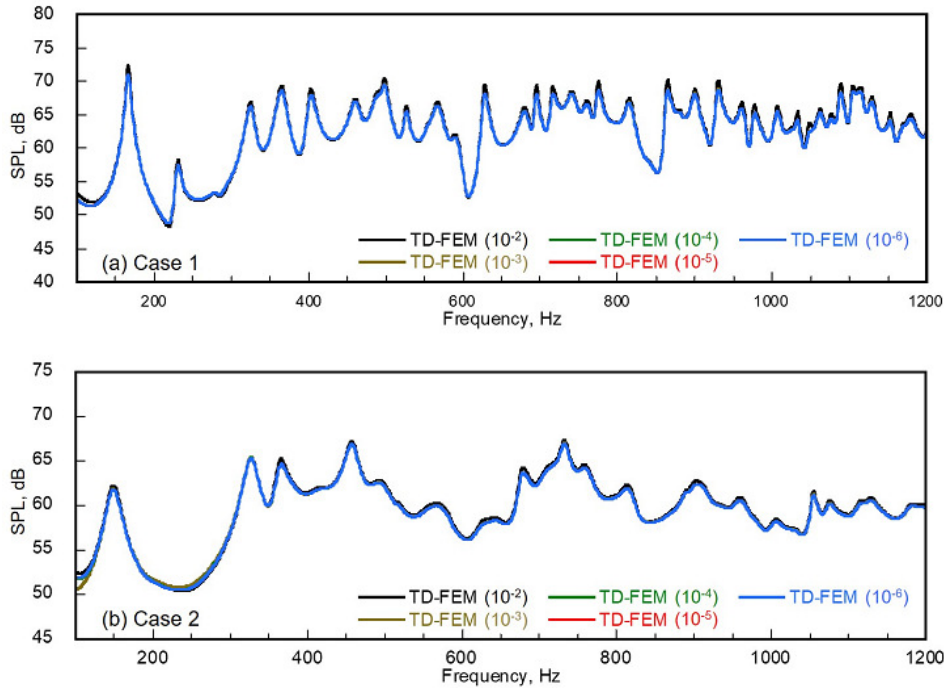
Figure A1. Comparisons of mean SPLs among the 4th-E TD-FEM with various tolerance values for ( a ) Case 1 and ( b ) Case 2, where the values in parentheses following TD-FEM represent the convergence tolerance for CR method.